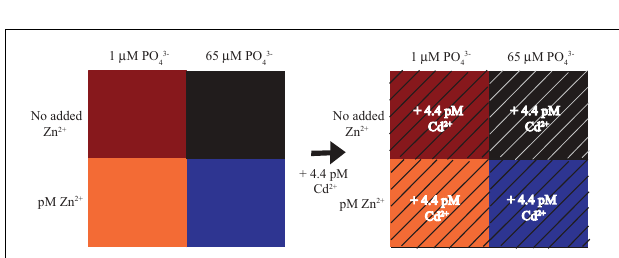
limitation reconnaissance study. Error bars are one standard deviation of triplicate 28mL tubes. Note that no PO 43 − added treatments, both with and without Zn appear to have a stationary phase. 1 μ M PO 43 − treatments appear to have a brief stationary phase and then enter death phase, the Zn dying faster than the no Zn. The 5 μ M PO 43 − treatments fluoresced to a greater maximum than the 65 μ M PO 43 − .